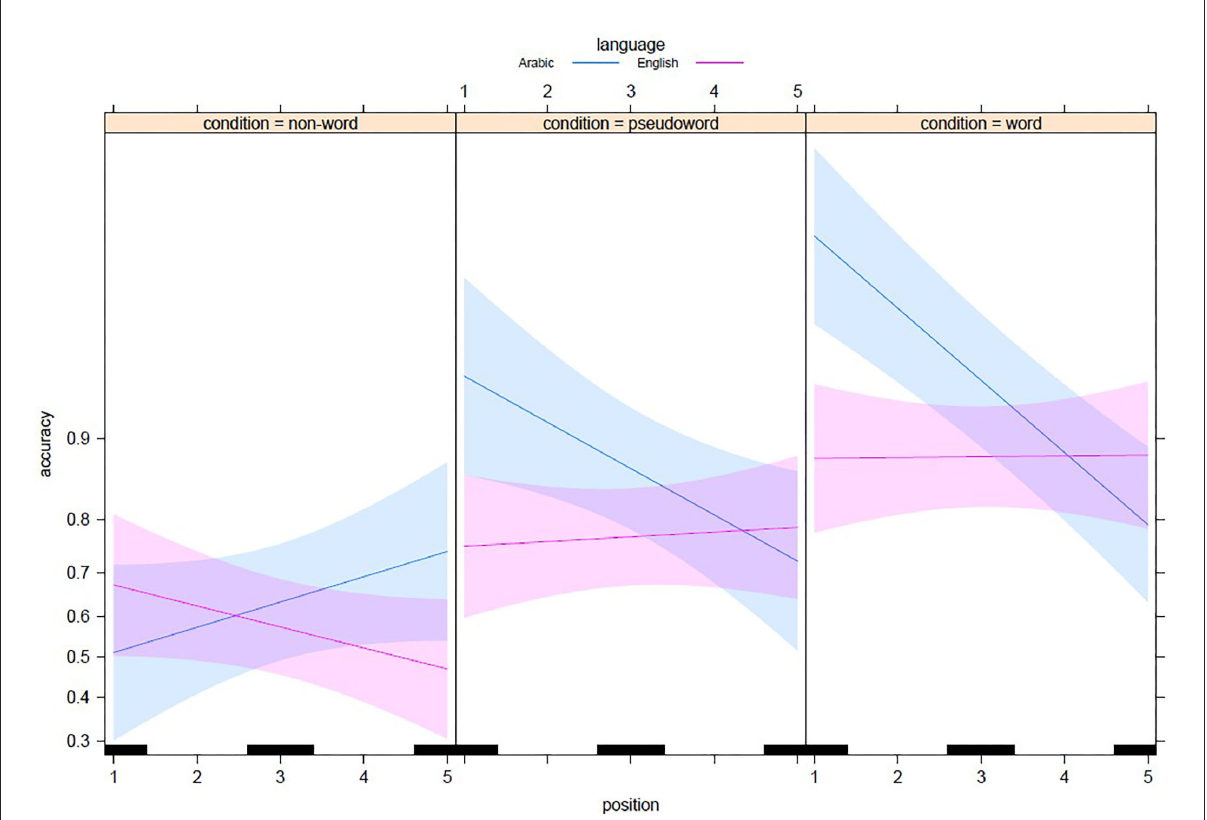
FIGURE6 Visualization of the GLME model predictions for the word superiority effect in Arabic and English as a function of String type and Position. The bands correspond to the confidence interval for each regression